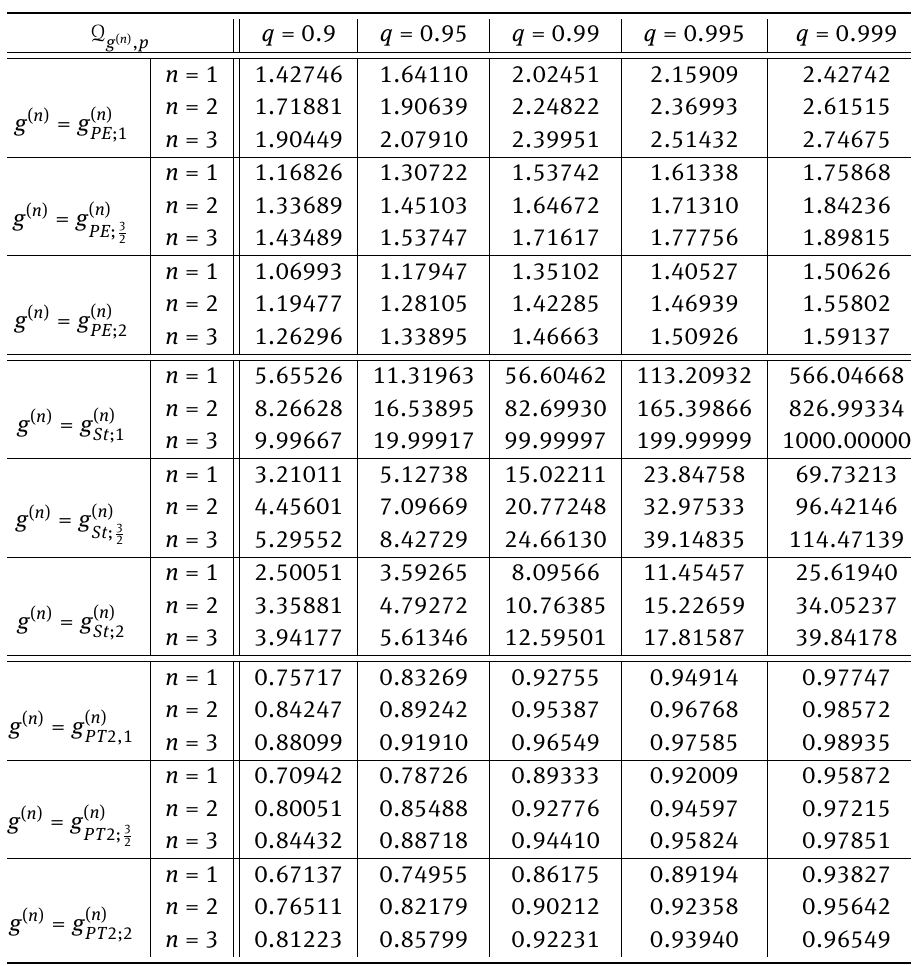
w.r.t. B n , p are computed for q ∈ { 0.9, 0.95, 0.99, 0.995, 0.999 } , p = 3 and for several